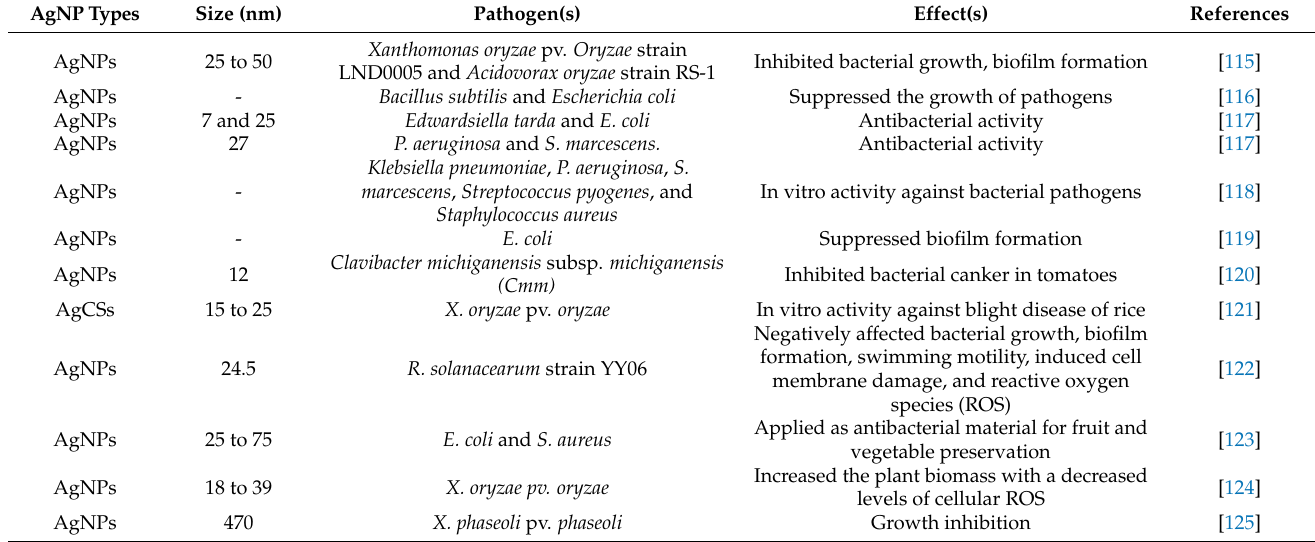
Table 4. AgNPs in bacterial disease